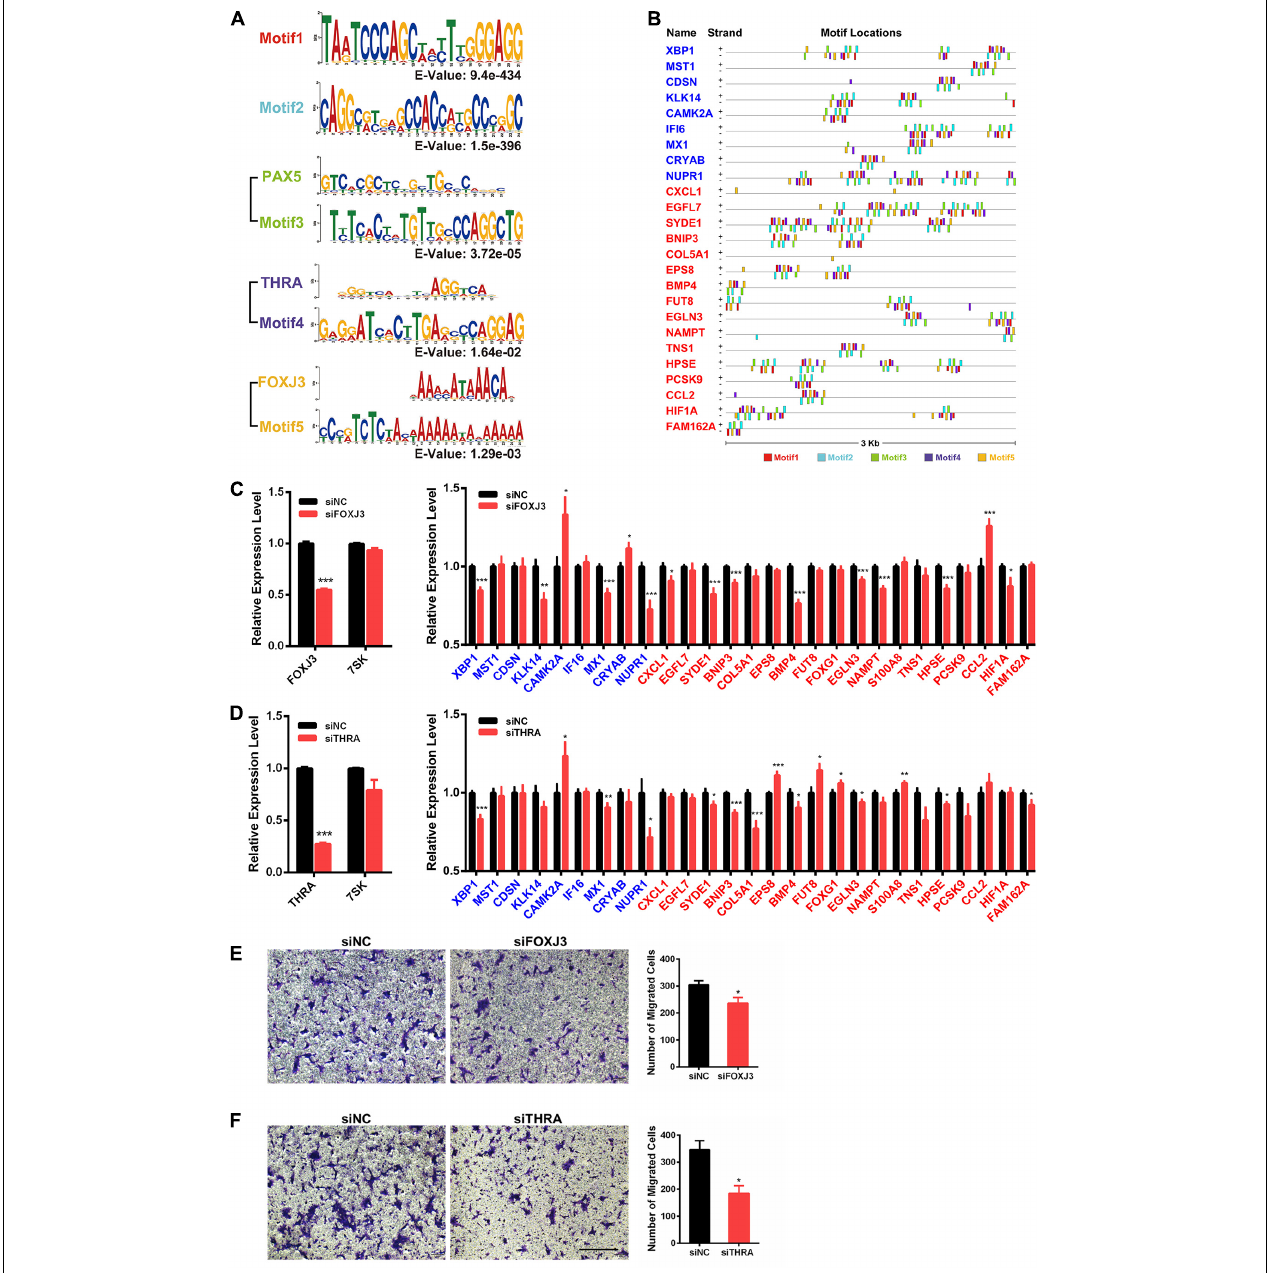
FIGURE 4 | Identification of FOXJ3 and THRA as two transcription factors that oppositely regulate 7SK associated genes and SCC15 migration. (A) The top five motifs (including FOXJ3 and THRA ) identified on the upstream regulatory regions of the 27 7SK associated genes. (B) Motif distributions on the upstream regulatory regions of the 27 7SK-associated genes. (C,D) RT-qPCR of FOXJ3 , THRA , 7SK, and the 27 7SK-associated genes in the presence of siFOXJ3 (C) and siTHRA (D) treated SCC15 cells. (E,F) The representative images (left) and the according statistical analysis (right) of transwell assay after FOXJ3 (E) and THRA (F) knockdown. The scale bar is 100 µ m, n = 3. * P <